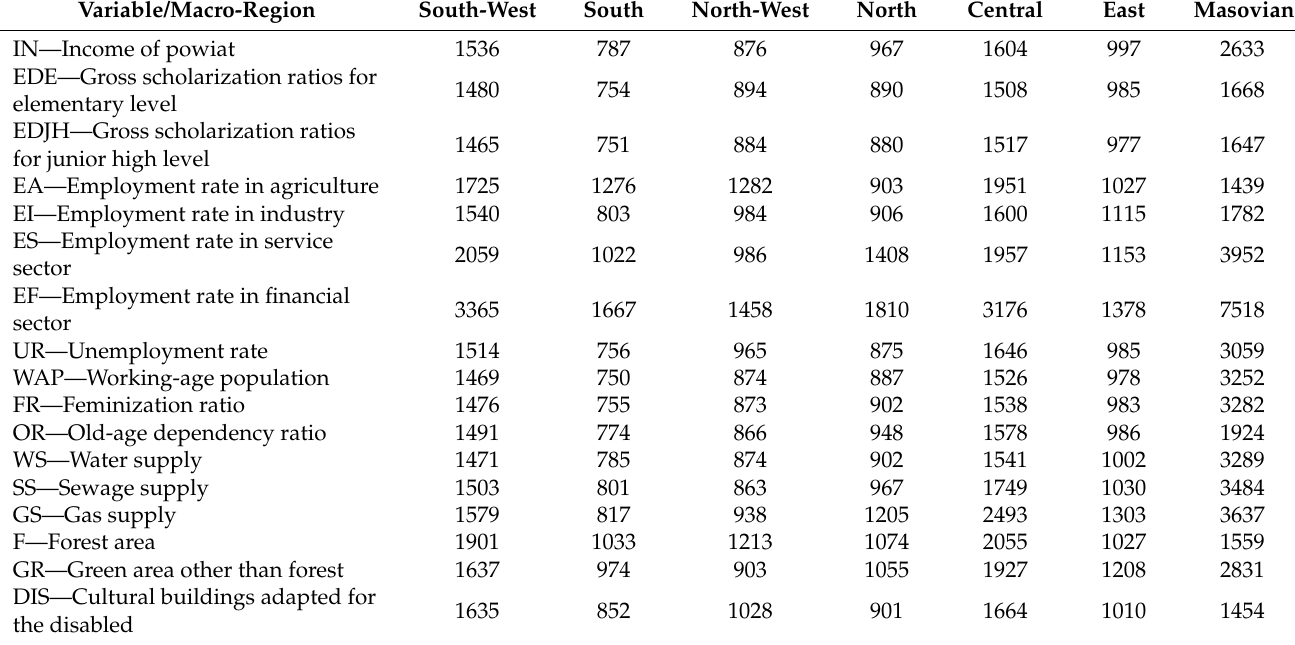
Figure 2. Within-voivodeship inequality. Source: Author’s calculation. Legend for Fig 1 and 2: (DL)—Lower Silesian, (K-P)—Kuyavian-Pomeranianranian, (LE)—Lubelskie, (LU)—Lubuskie, (Ł)—Ł ó d˙z, (MŁ)—Lesser Poland, (O)—Opole, (PK)—Podkarpackie, (PL)—Podlaskie, (PO)—Pomeranian, (´SL)—Silesian, (´SW)—´Swietokrzyskie, (W-M)—Warmian-Masurian, (WL)—Wielkopolska, (ZP)—Zachodniopomorskie, (MAZ)—Masovian, (W-stoł)—Warsaw—Capital, (MAZ_R)—Masovian—regional. Table 7. The HHI values for the socioeconomic determinants of health in Poland in 2018.